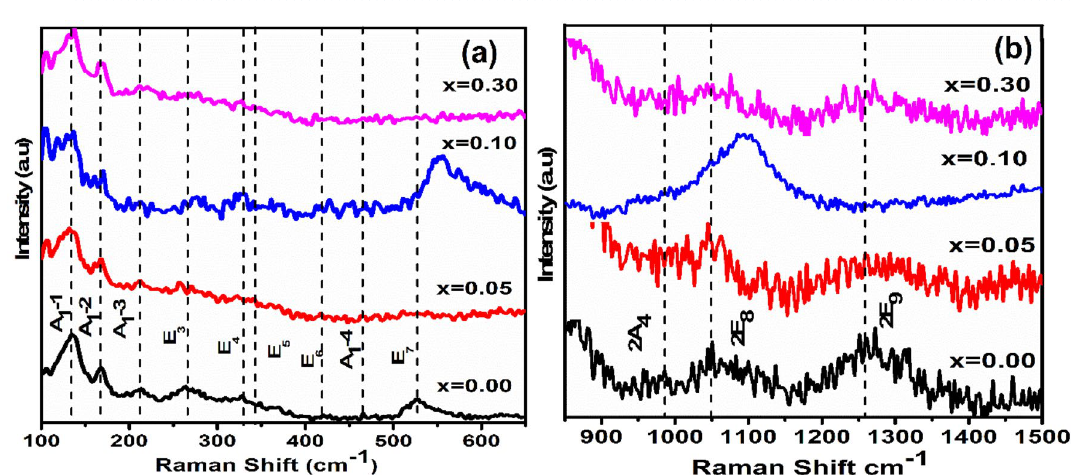
Figure 5. High resolution transmission electron microscope image of (1 − x) BFO–xCFO, [x = 0.00 ( (a,b) , 0.05 (c,d) , 0.10 (e,f) , 0.30 (g) , CFO)] samples.